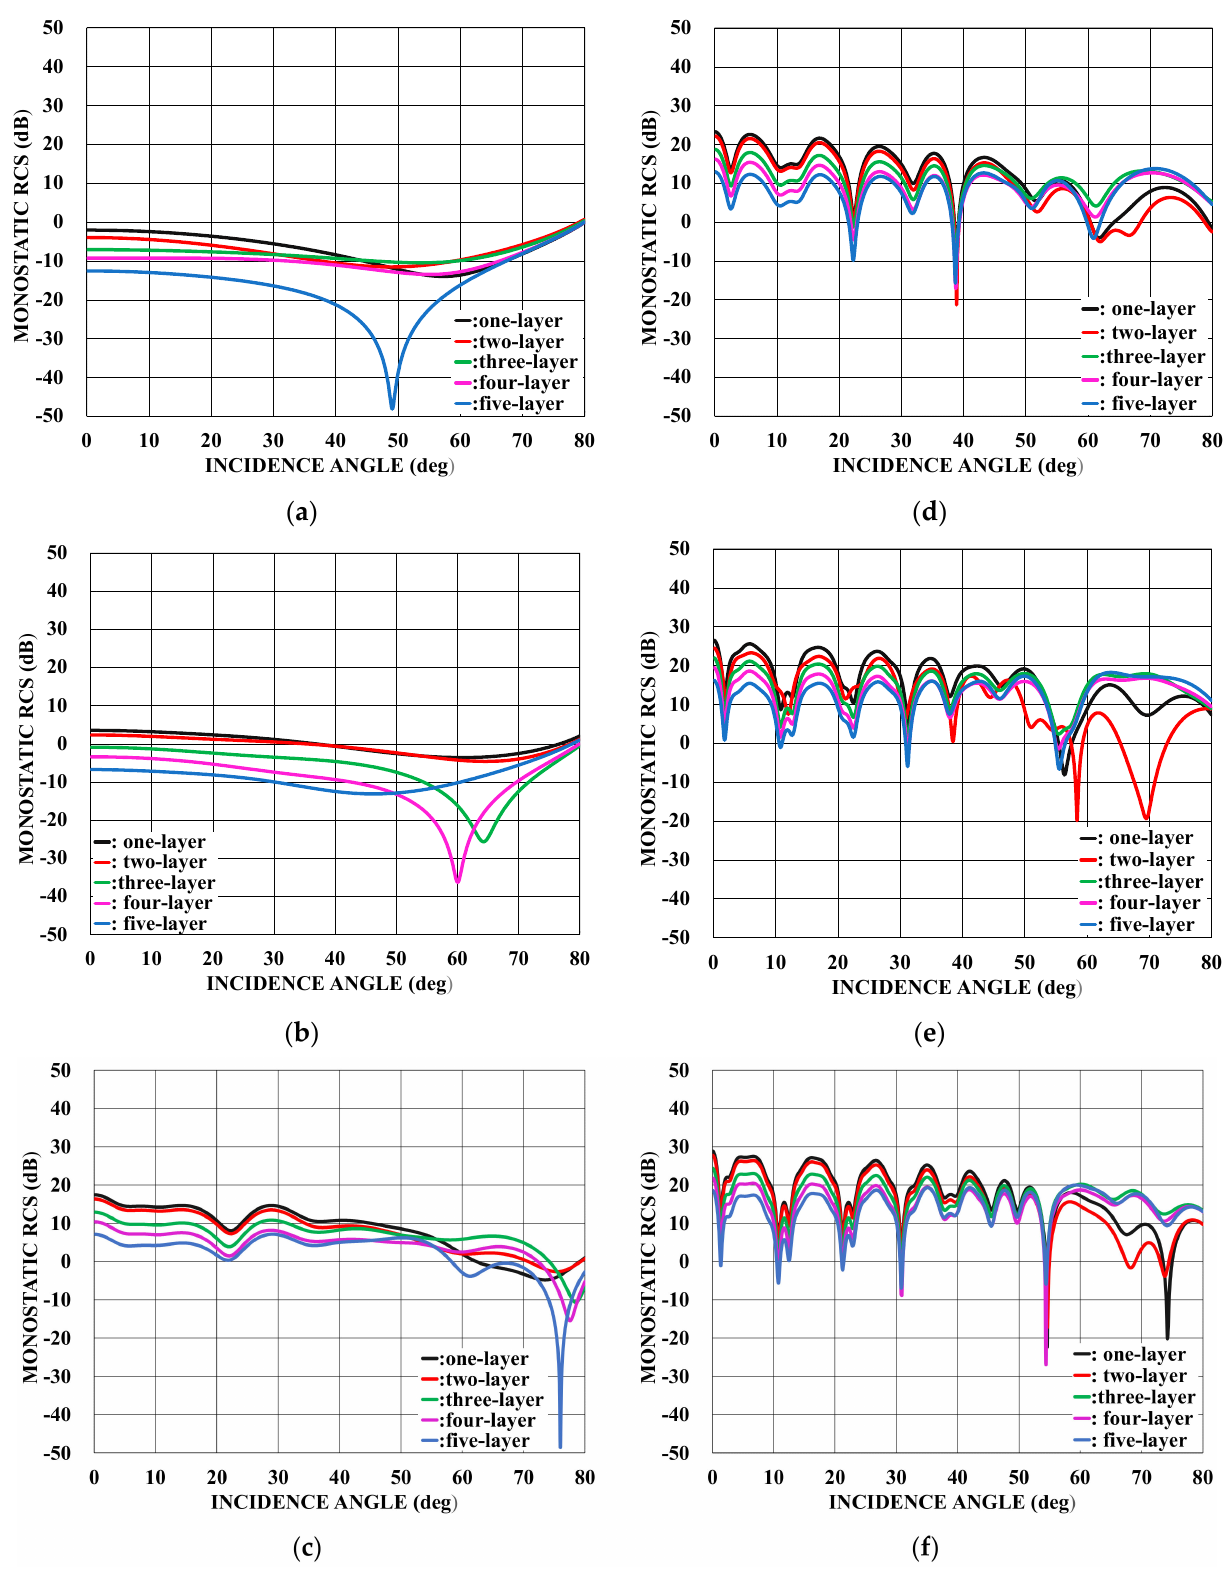
Figure 5. Monostatic RCS [dB] versus incidence angle θ 0 for L 1 /2 b = 5.0, kt = 1.57. Other particulars are the same as in Figure 2. ( a ) kb = 1.57. ( b ) kb = 3.14. ( c ) kb = 15.7. ( d ) kb = 31.4. ( e ) kb = 47.1. ( f ) kb =